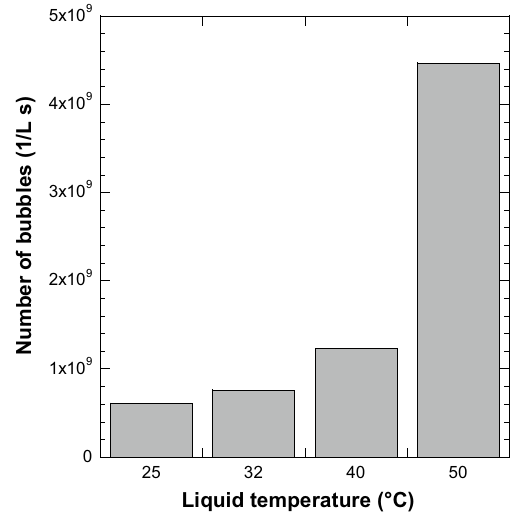
Fig. 3 Size of active bubbles for the production of oxidants (condi- tions—ambient bubble radius: 0.2–3 µm, liquid temperature: 25 °C, static pressure: 1 atm, frequency: 1700 kHz, power: 15 W)